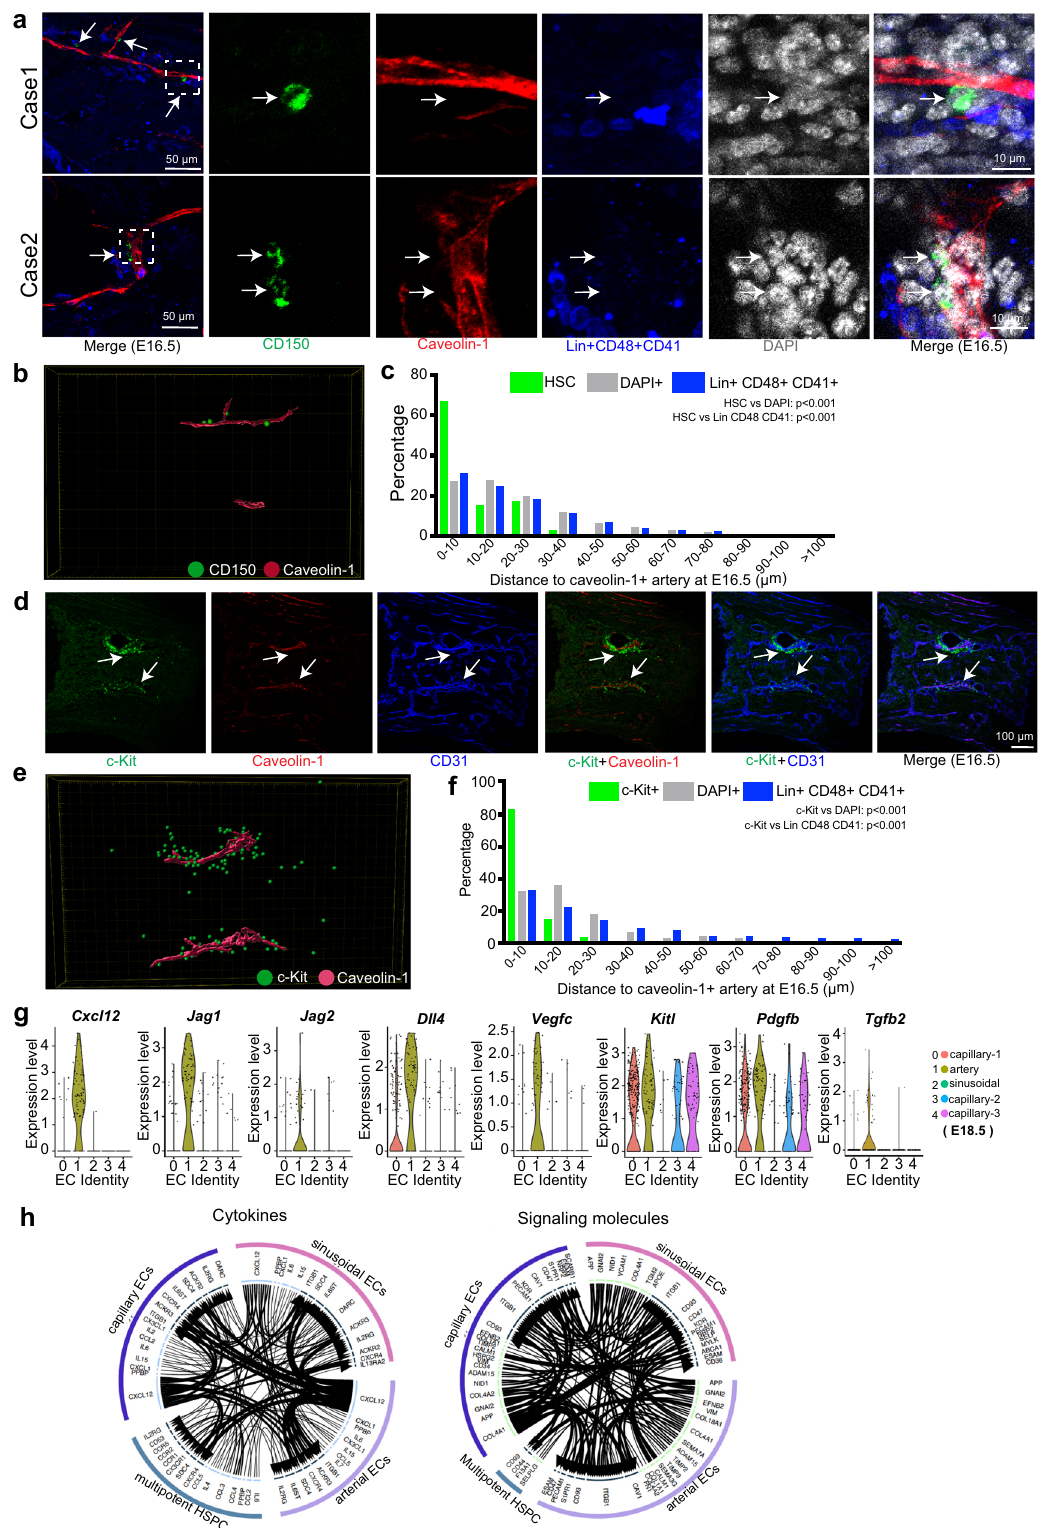
absence of the LepR + population re fl ects not just absent cell interactions. LepR + reticular cells, a stromal cell population that is associated with sinusoidal vessels and provides essential expression of a single gene, namely Lepr , but the actual lack of a niche signals for HSPCs in the adult organism 18,19,55 , are absent BMSC subcluster in fetal BM. As LepR + perivascular cells in fetal marrow. This fi nding is consistent with previous pub- become abundant at 2 weeks after birth, one possibility is that lications using immunostaining and FACS to investigate BMSC their function is taken over by another population of perivascular development 54 – 56 , but our scRNA-seq analysis suggests that mesenchymal cells in the embryo and during early postnatal NATURE COMMUNICATIONS| (2022) 13:1327